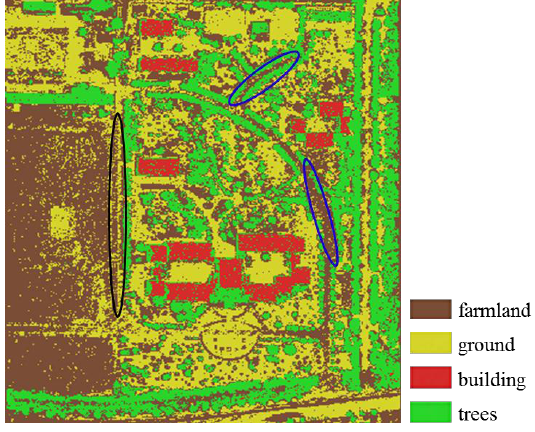
Figure 6. Land cover classification results of Miyun area based on ANNs method